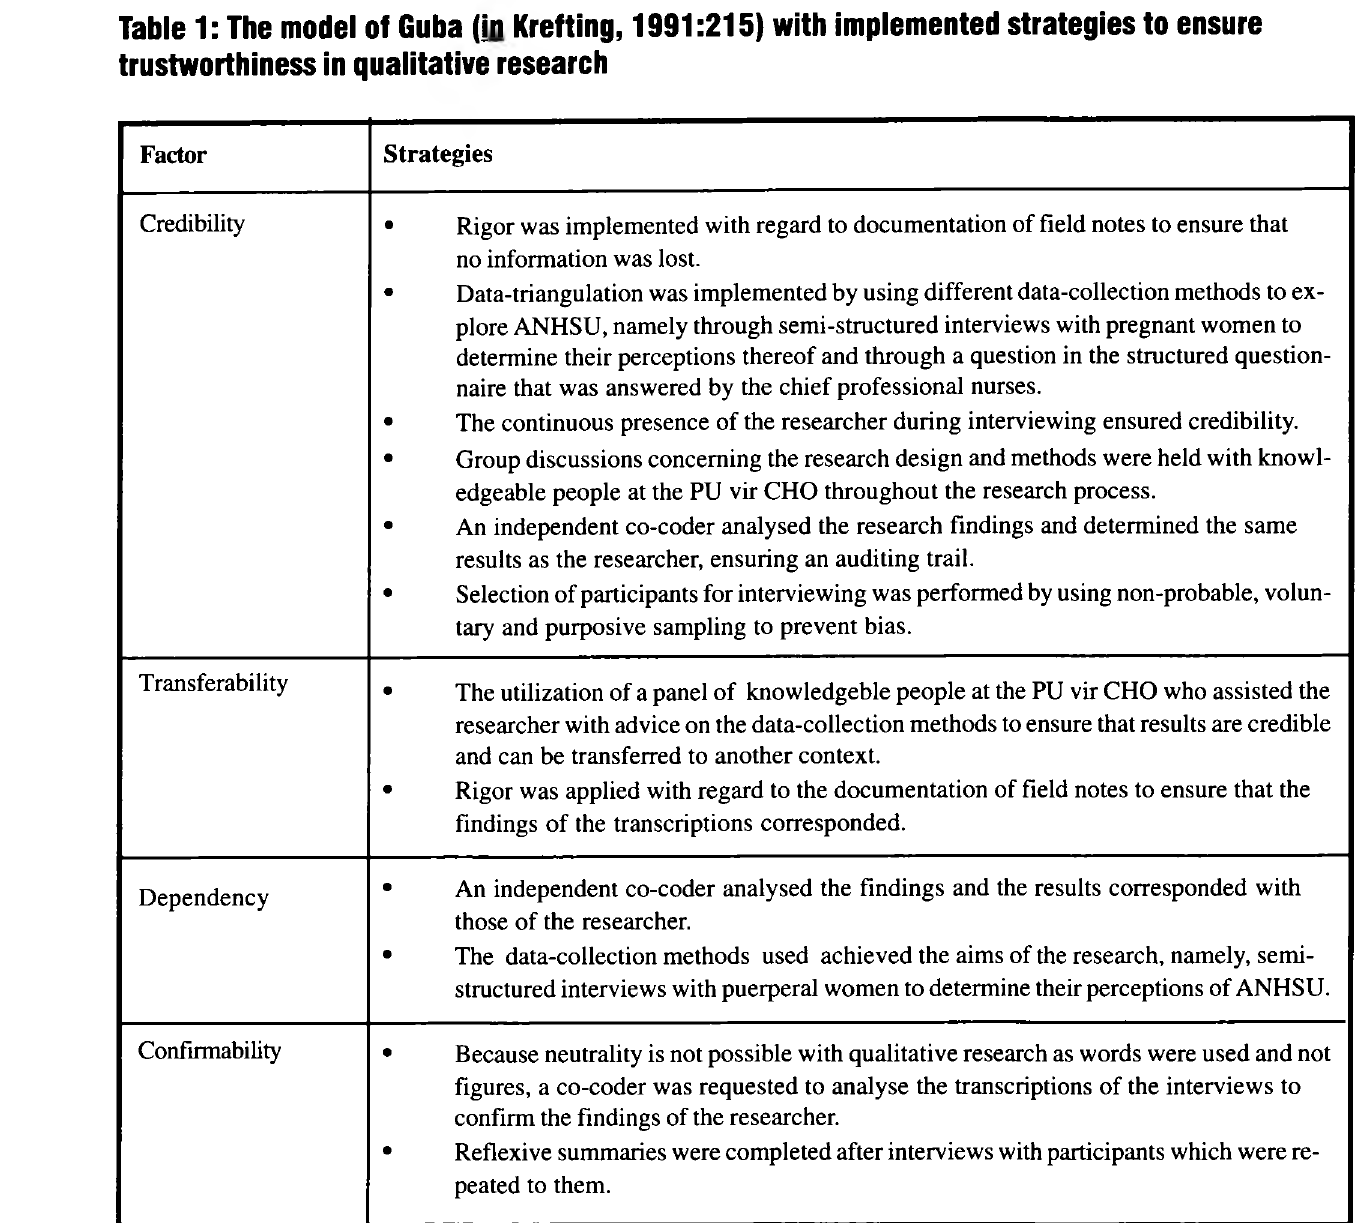
Table 1: The model of Guba (in Krefting, 1991:215) with implemented strategies to ensure trustworthiness in qualitative research Factor Strategies